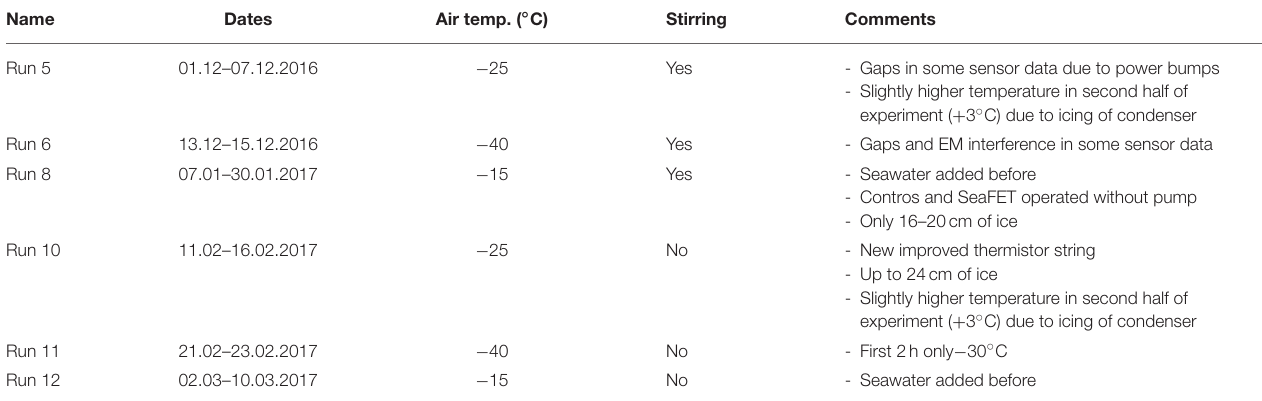
TABLE 1 | Overview of experimental